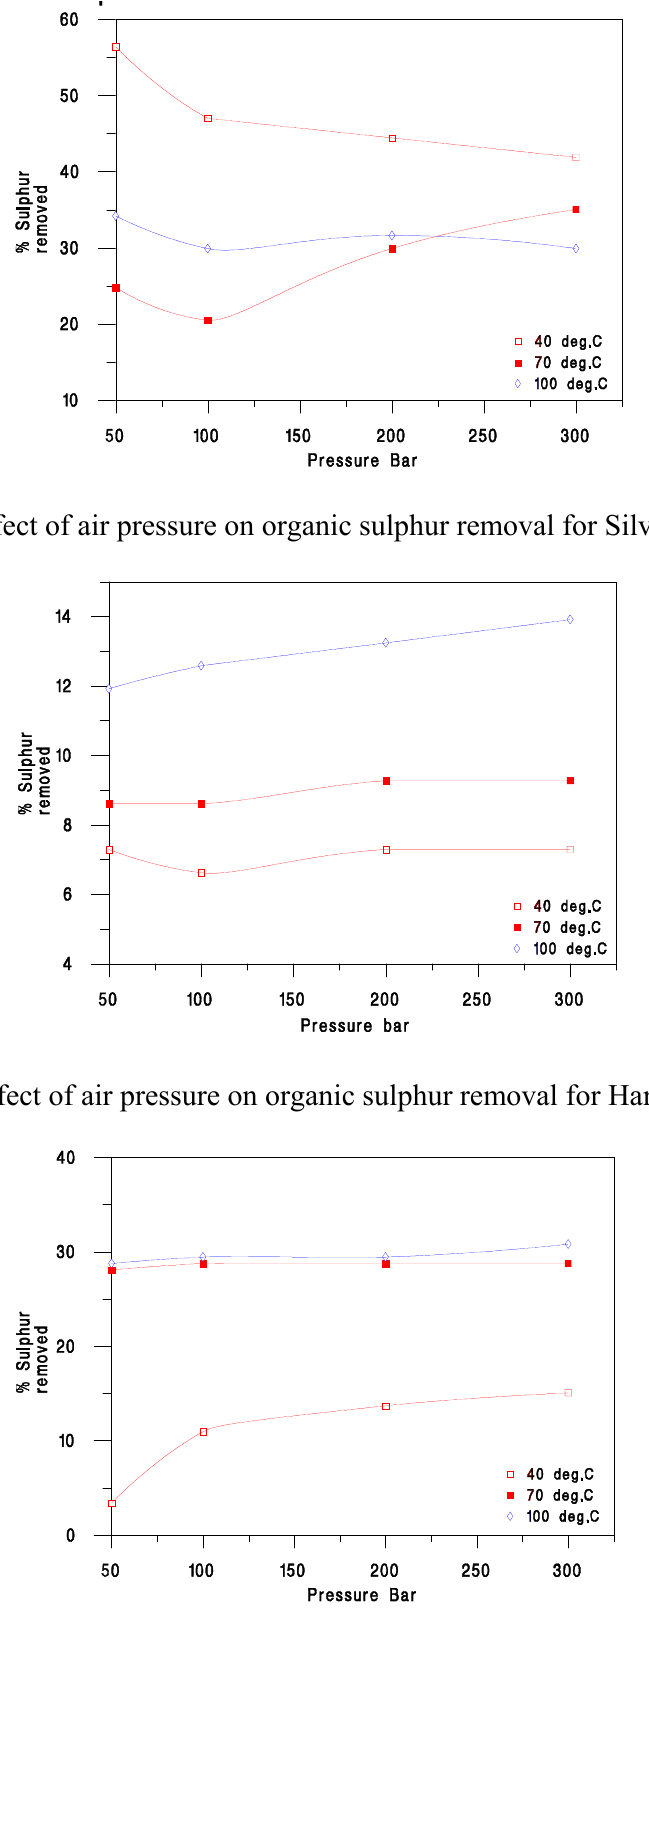
Figure 5. Effect of air pressure on organic sulphur removal for Prince of Wales coal.